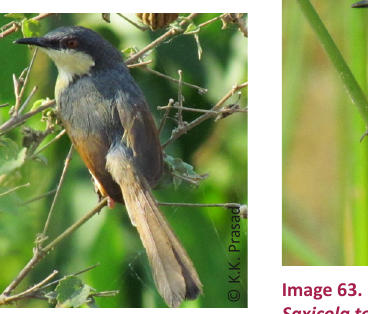
catcher Cyornis